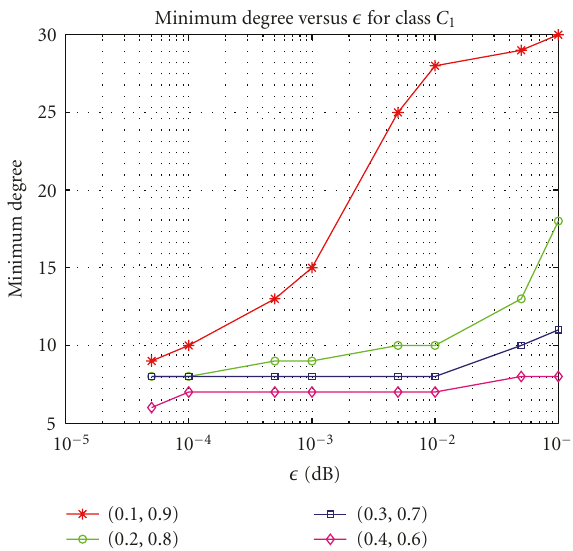
Figure 1: Minimum bit node degree for class 1 versus (cid:2) . As ex- pected, the minimum bit node degree increases with (cid:2) . The increase is faster when proportions associated with the class 1 are low.